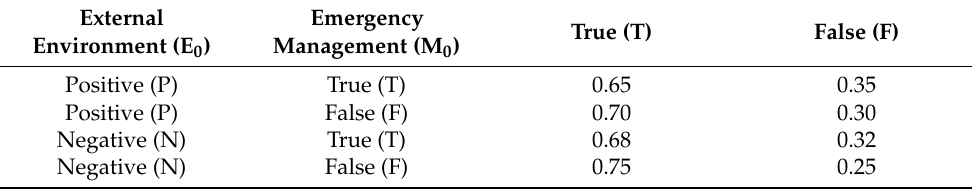
Table 6. Conditional probability of S 0.